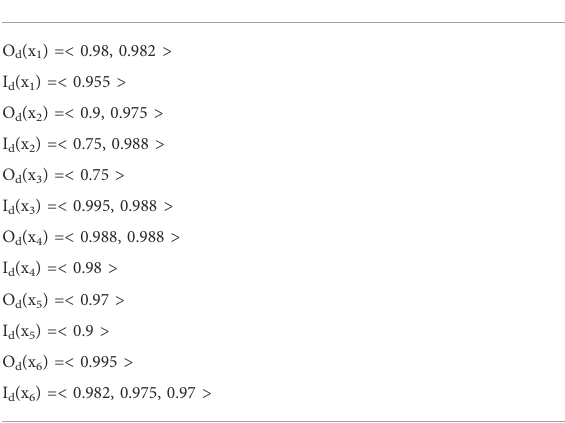
TABLE 11 Out-degree and in-degree of every